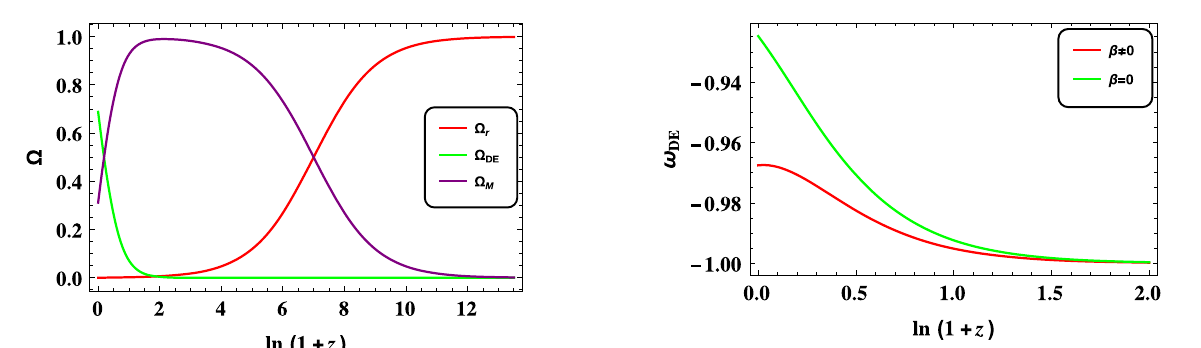
Fig. 1 Variations of density parameters with redshift